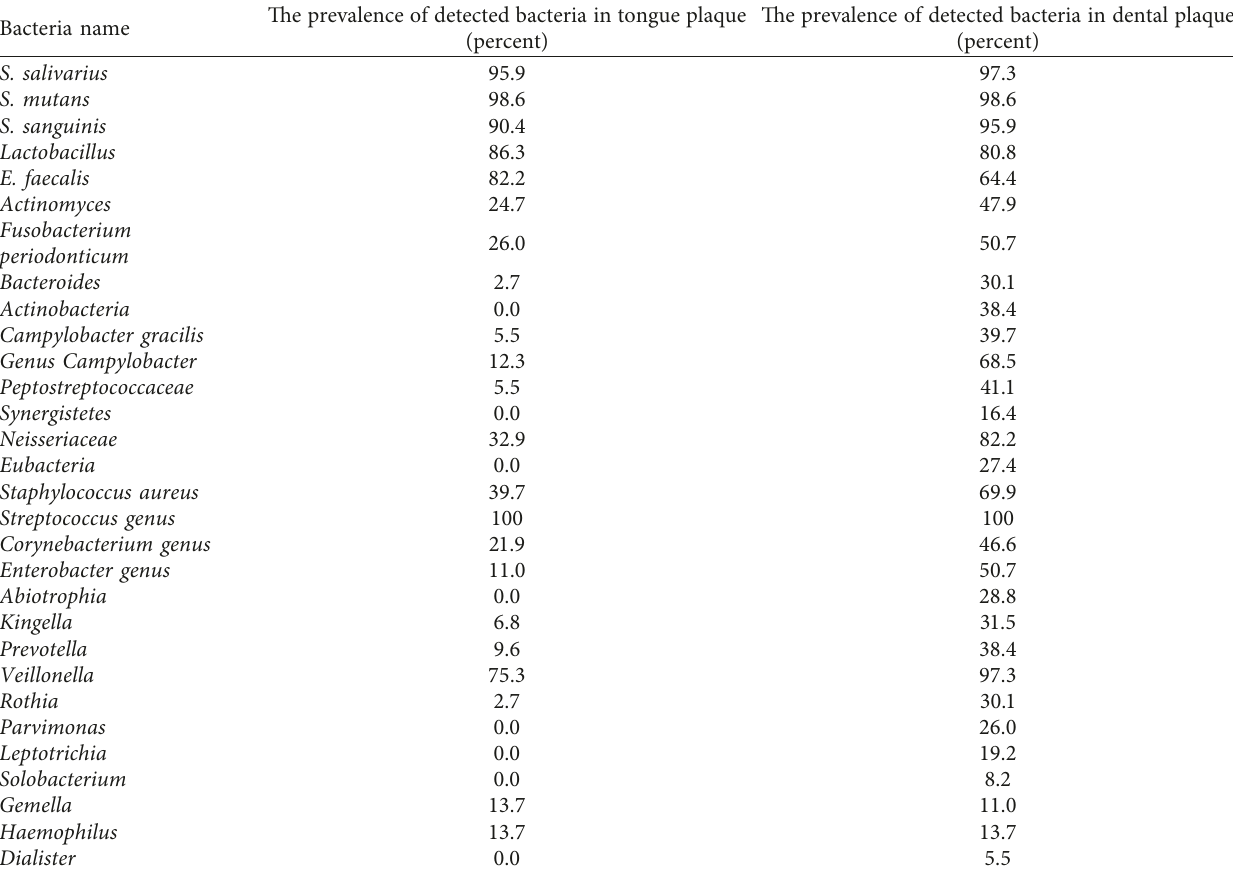
Table 4: The prevalence of different bacteria in the dental plaque and tongue